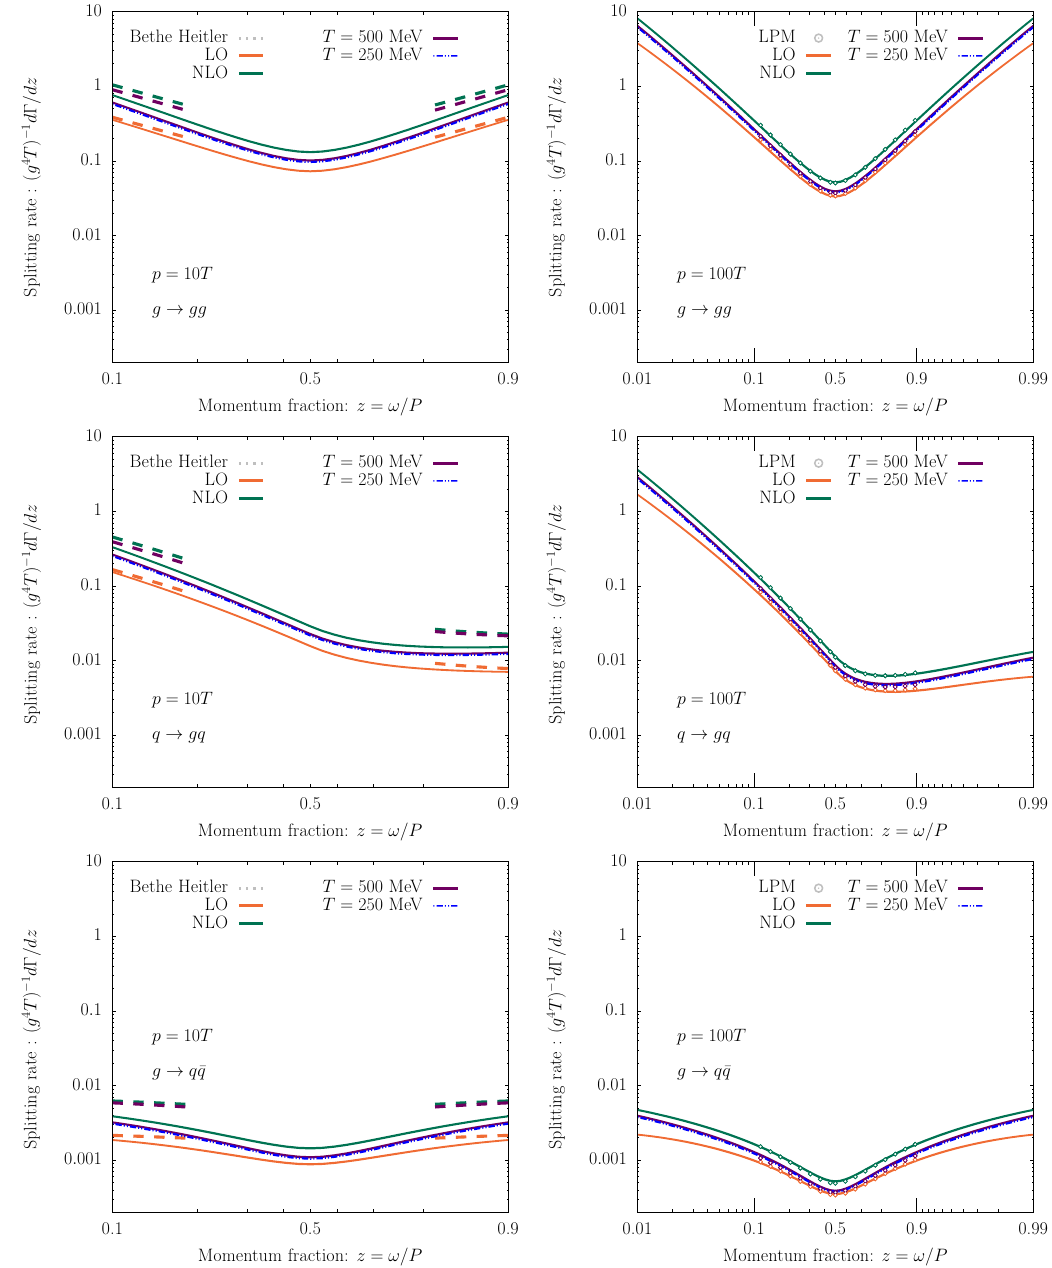
Figure 3. Splitting rate at T = 250 MeV (dashed blue lines) and T = 500 MeV (full purple lines) for the processes g → gg (top), q → gq (middle), g → qq (bottom). Different columns correspond to parent energies p = 10 T (left) and p = 100 T (right). We compare with rates computed using the perturbative leading order (orange) and next-to-leading order (green) elastic broadening kernels. The Bethe Heitler rates and LPM rates are shown with dashed lines and circles respectively, using the color of the corresponding